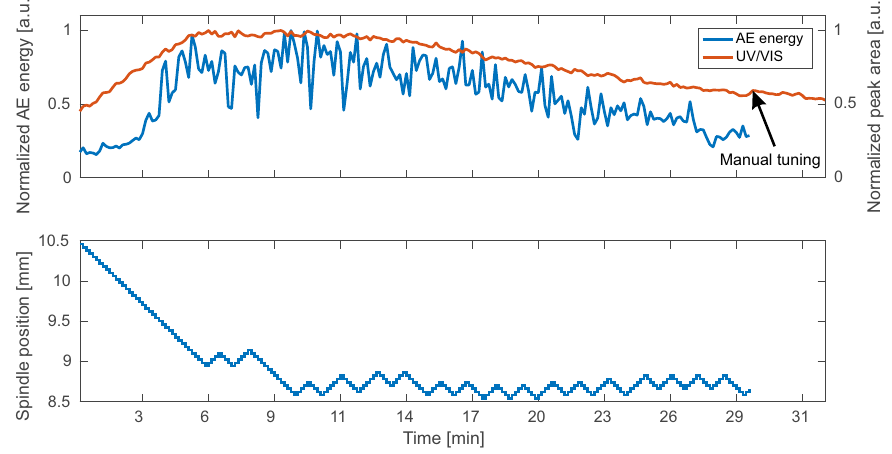
Figure 5. Automatic positioning results: experimental run